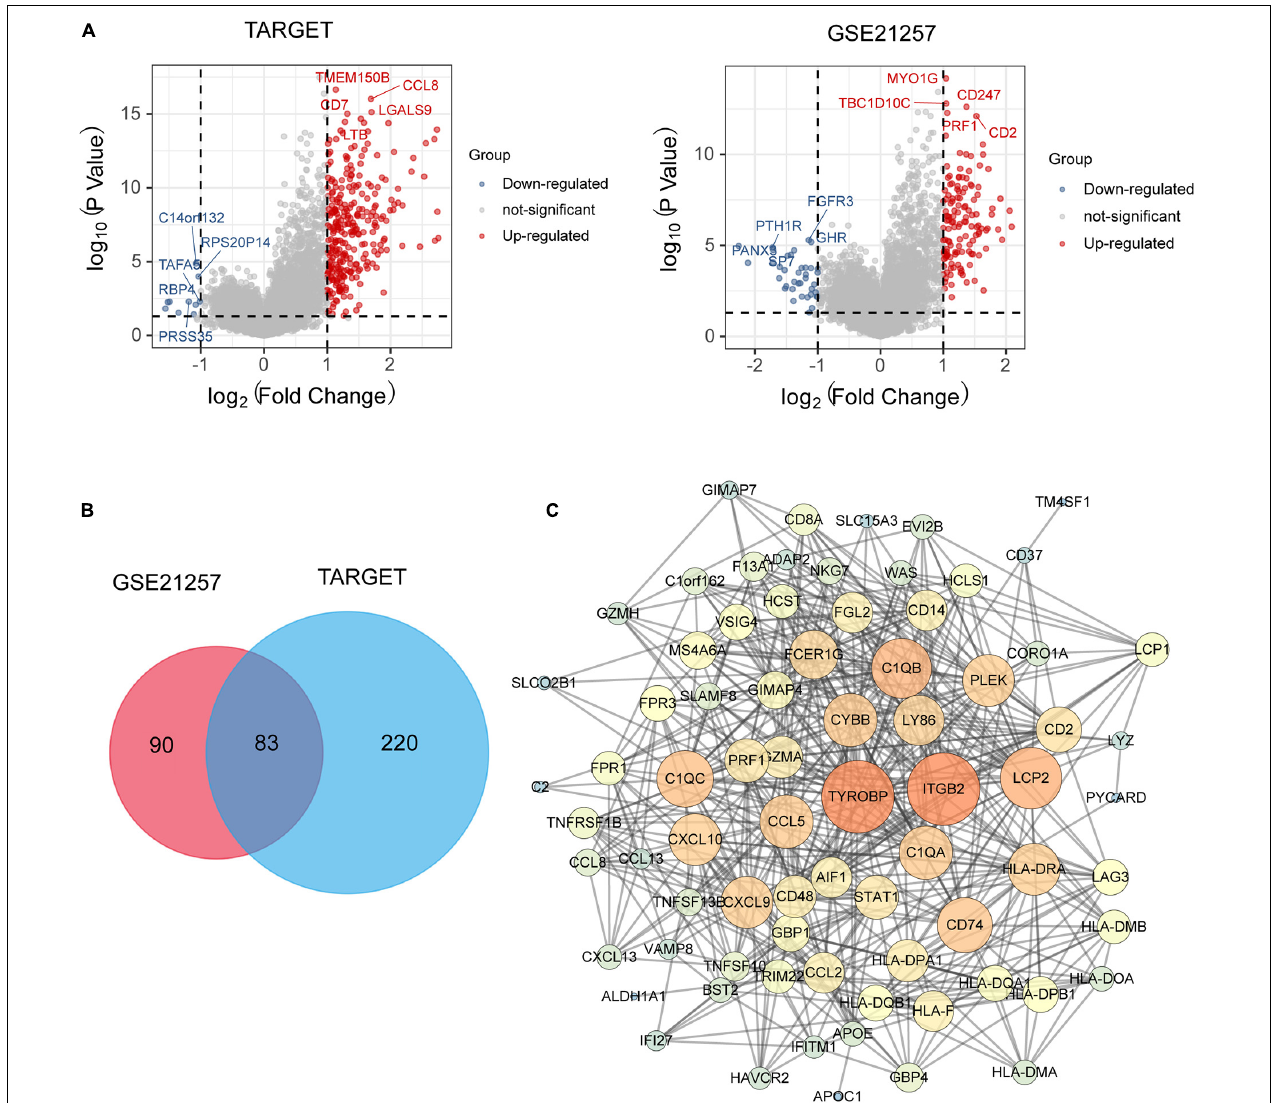
FIGURE 4 | (A) Volcano plot presented distribution of differentially expressed genes (DEGs) quantified among Immune_H and Immune_L subtypes with threshold of | log2 Fold change| > 1 and P < 0.05 in TARGET and GSE21257 cohort; (B) Venn plot showed intersection of differentially expressed genes among Immune_H